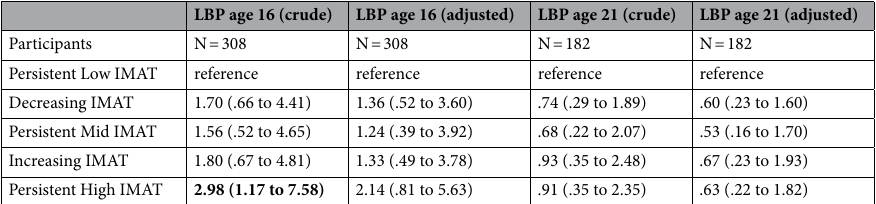
Table 4. Crude and adjusted odds ratios for patterns of change in lumbar multifidus intramuscular fat from age 13 to 16 and low back pain at age 16 and 21 a . a All values are odds ratios (95% confidence interval). Adjusted models included sex and BMI at age 21. Intramuscular adipose tissue is abbreviated as IMAT. Persistent low IMAT was used as a reference category. Significant values are in [bold].